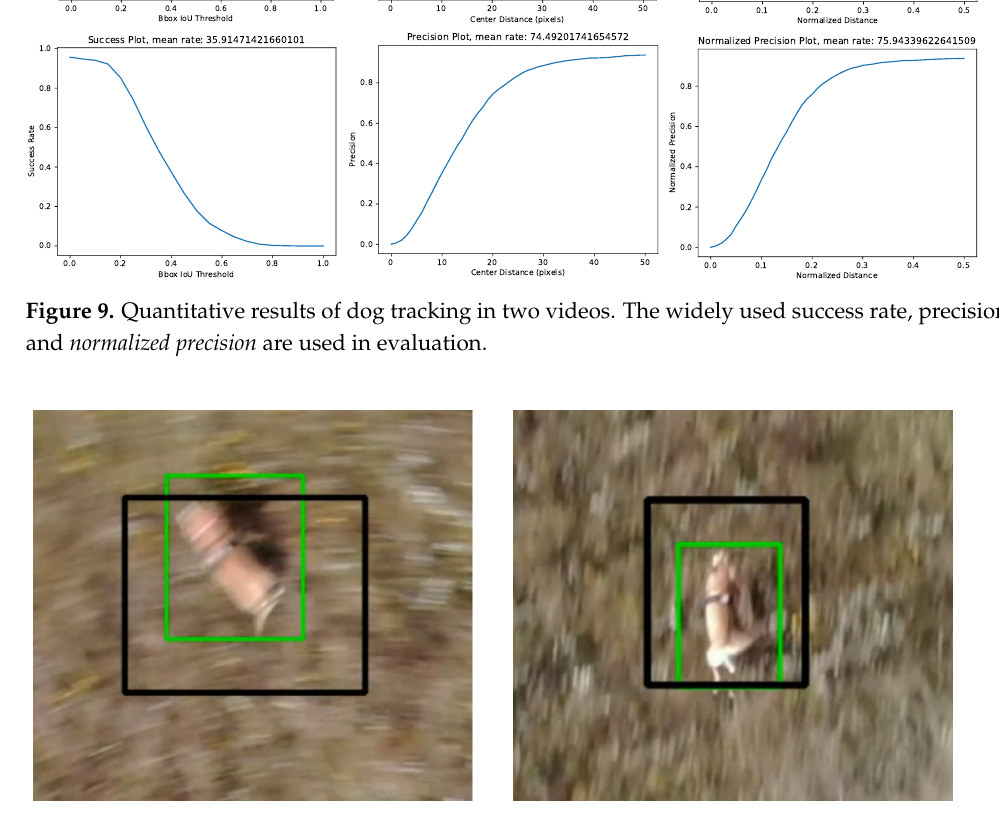
Figure 10. Illustration of the lack of compactness of the annotated bounding boxes (in black) in some frames, which may cause the not-very-high success rate in evaluation. The bounding boxes in green are tracking